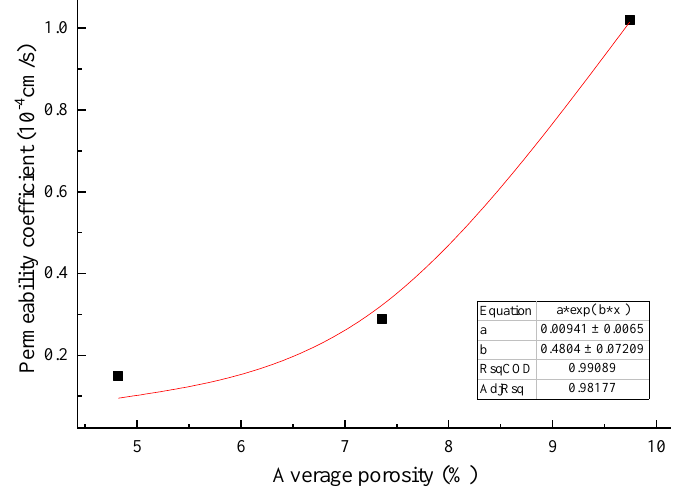
Figure 26. The fitting curve of the average porosity and permeability coefficient.